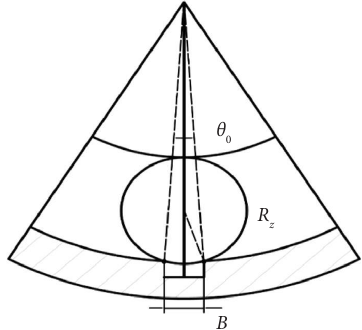
Figure 10: Outer race defect.